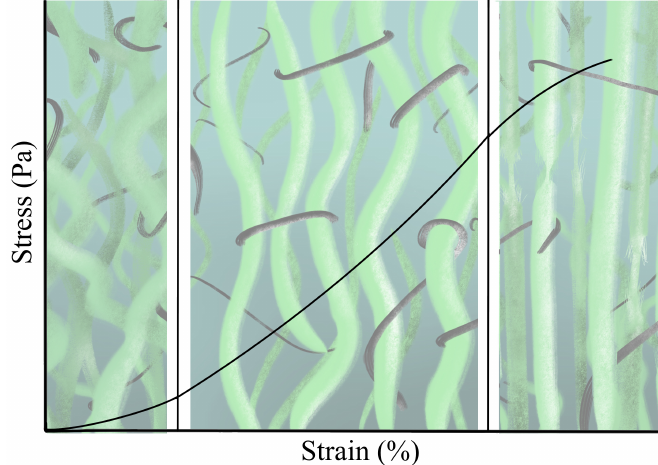
Figure 2. Stress–strain curve in soft tissues. The relationship is divided into three regions; namely, the toe, the nearly linear, and the failure regions: in the first, elastin fibers absorb